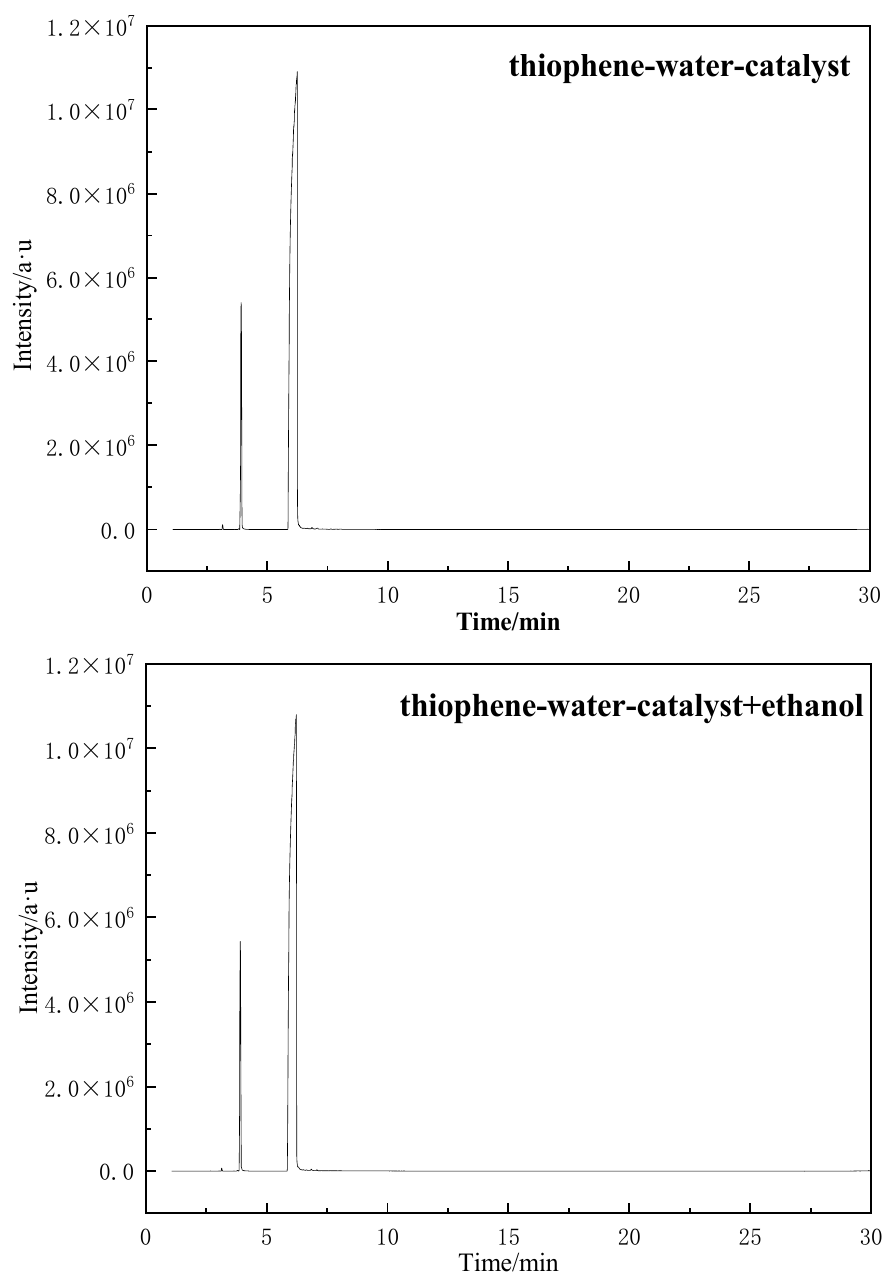
Figure 10. GC curves of thiophene under different reaction conditions.